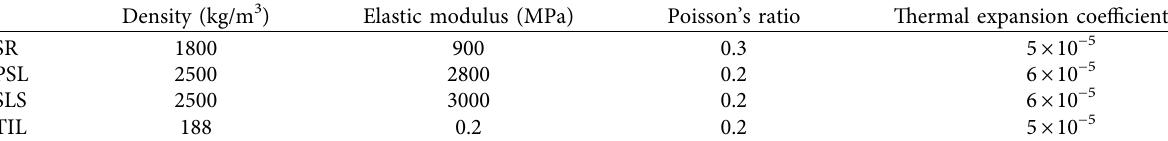
Table 3: The physical parameters of lining structure and SR in numerical simulation.